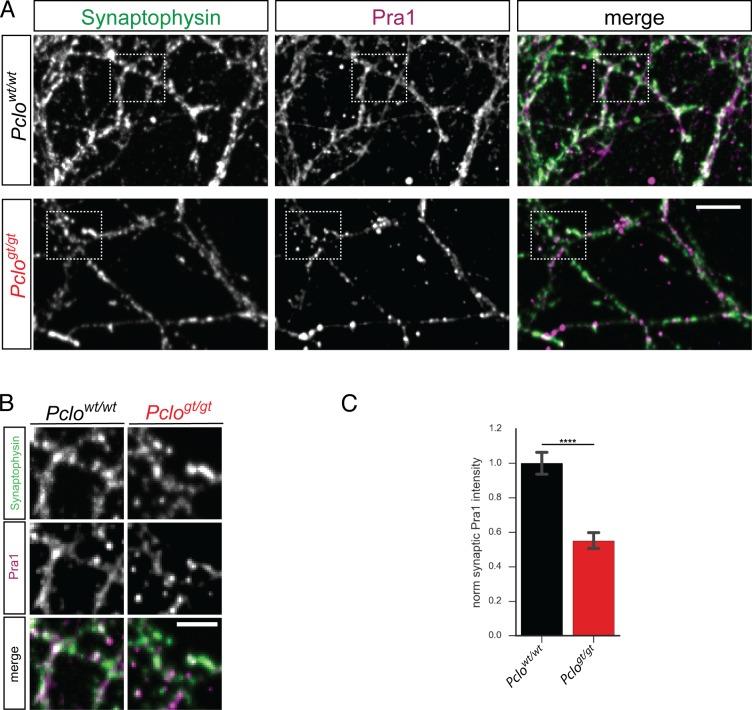
The loss of Piccolo leads to diminished levels of synaptic Pra1.(A) Images of Pclowt/wt and Pclogt/gt neurons stained with Synaptophysin and Pra1 antibodies. Pra1 is present at Synaptophysin positive synapses in Pclowt/wt synapses but is reduced in Pclogt/gt synapses. (B) Detail images of areas indicated in (A). (C) Quantitation of (A). Loss of Piccolo decreases Pra1 intensity at synapses compared to Pclowt/wt synapses (Pclowt/wt = 1 ± 0.03, n = 474 synapses; Pclogt/gt = 0.55 ± 0.02, n = 723; three independent experiments). Scale bar represents 10 μm and 5 μm in zoom image, Error bars in bar graph represent 95% confidence intervals. Numbers given represent mean ± SEM, Student`s t –test. **** denotes p<0.0001.10.7554/eLife.46629.027Figure 9—source data 1.This spreadsheet contains the normalized values used to generate the bar plots shown in Figure 9C.